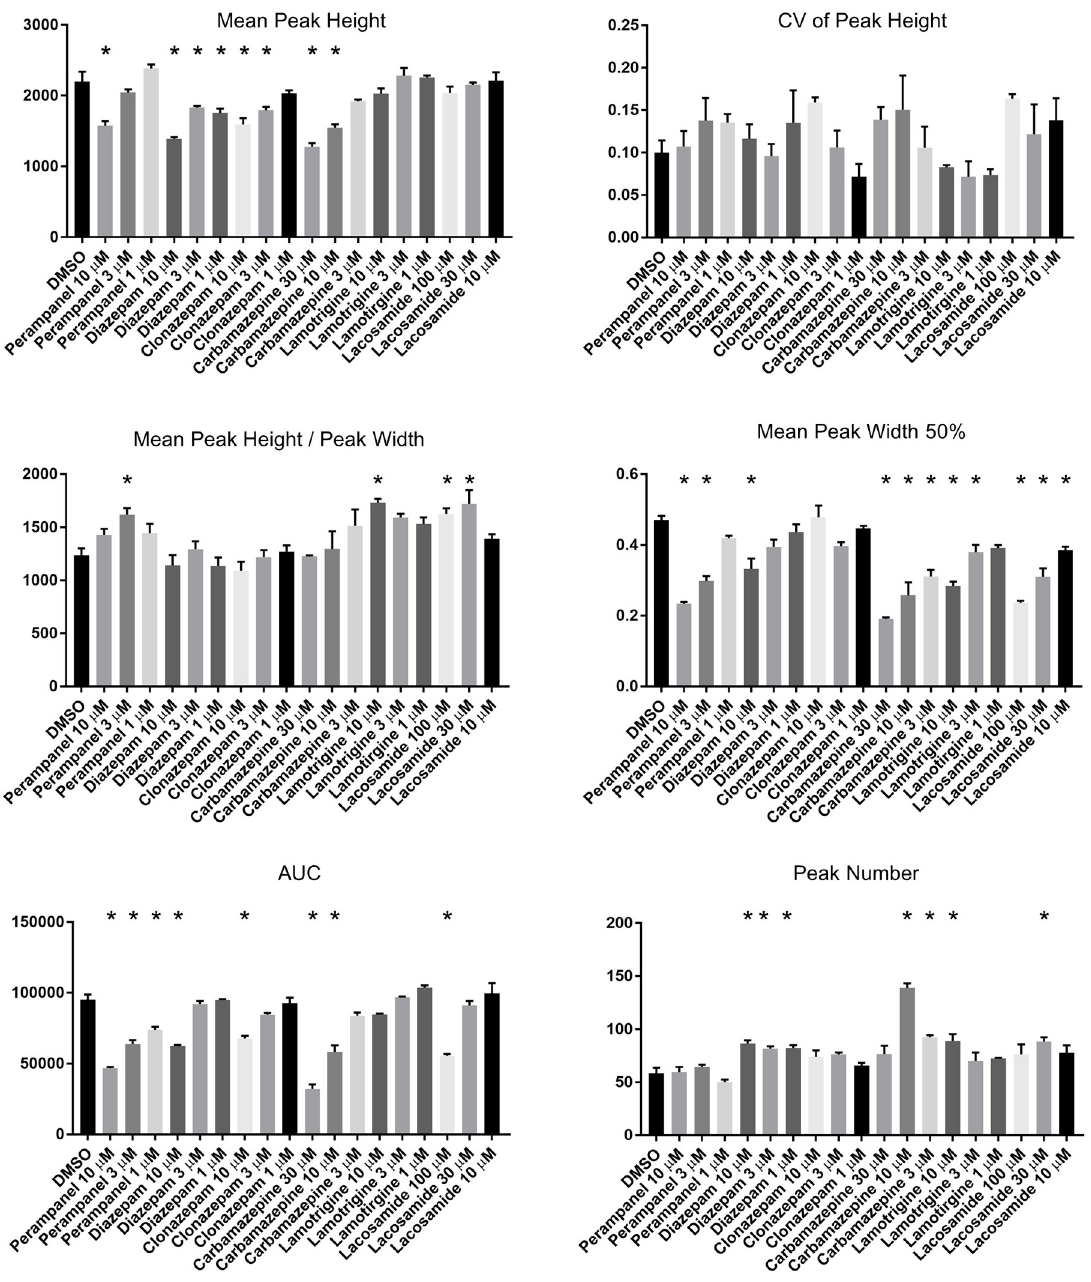
Fig 4. The changes of wave features in response to treatment with AEDs at three concentrations. Bar plots of features extracted from wells to which AEDs were treated. Features were calculated and averaged from 3 wells per AED under each condition, also containing DMSO. Data are means ± SEM (n = 3 wells). p * < 0.05 vs. DMSO (n = 47–145 peaks per well, one-way ANOVA with Dunnett post-hoc